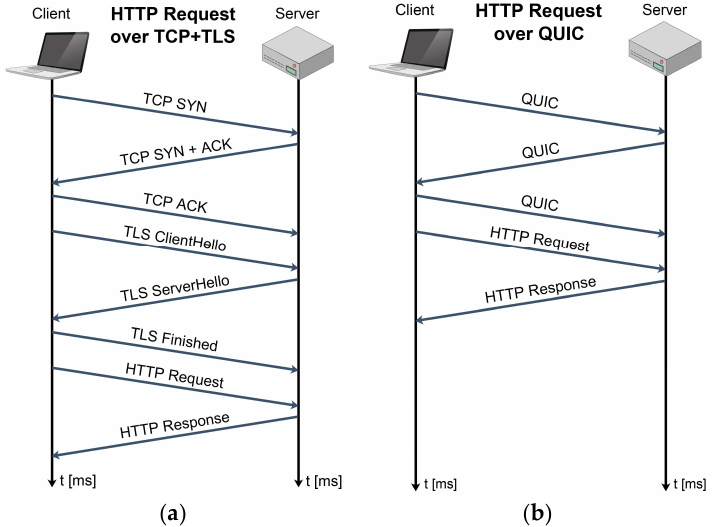
Figure 7. Comparison of connection establishment and message exchange for: ( a )TCP with TLS, ( b ) QUIC protocol.